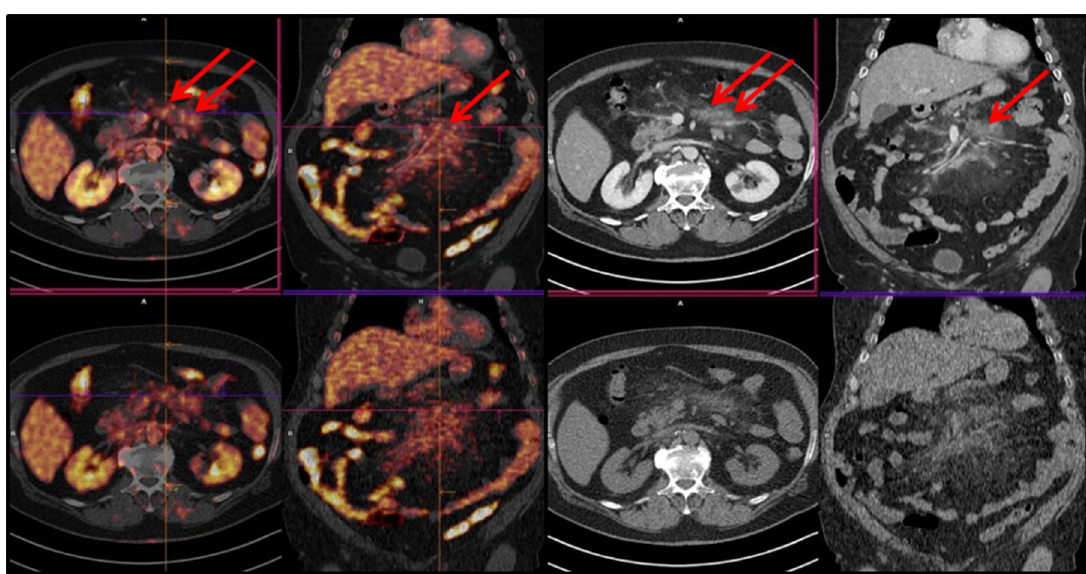
Figure 4. PET/ceCT highlighted additional lesions in mesenteric area [DS 4; SUVmax